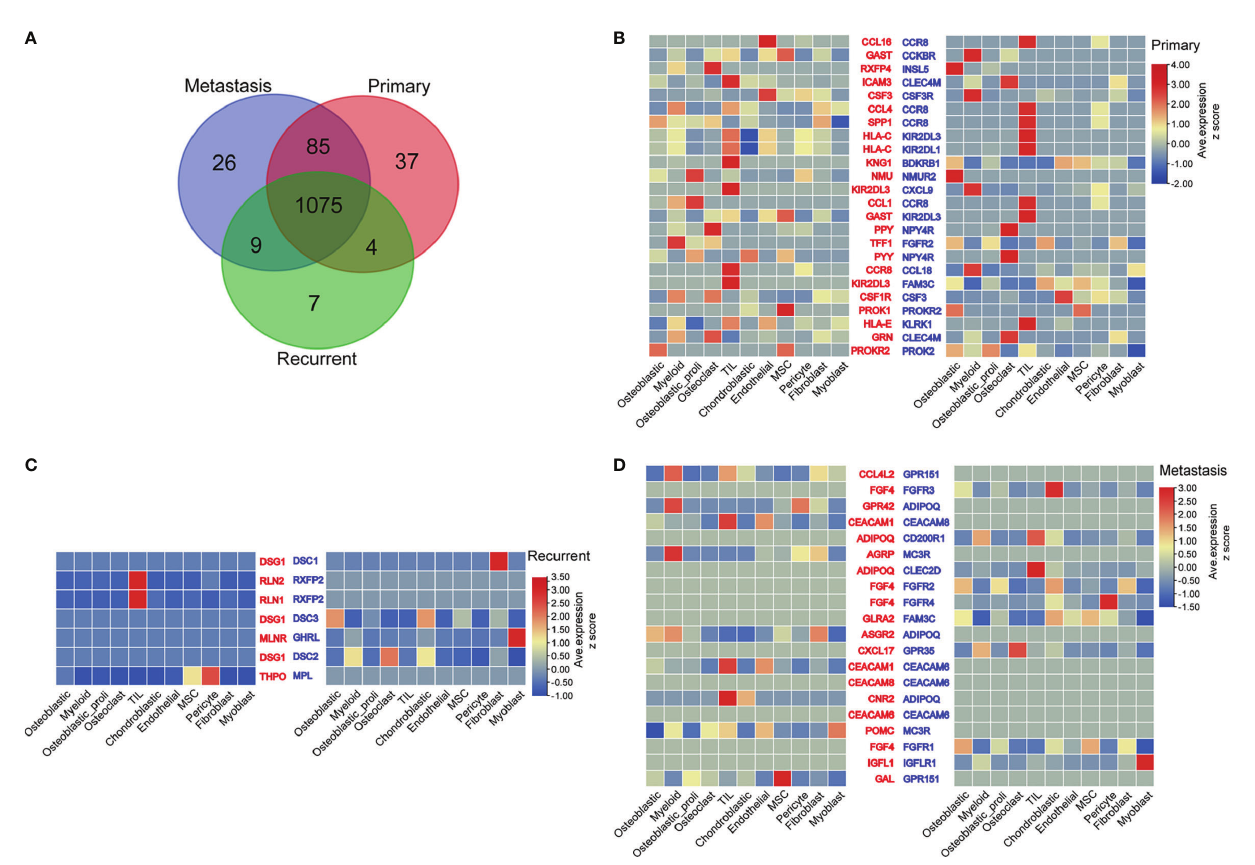
FIGURE 4 | Ligand – receptor interactions between various types of cells from primary, metastatic, and recurrent osteosarcomas. (A) The common ligands/receptors in primary, metastatic, and recurrent osteosarcomas were illustrated as a Venn diagram. (B) The expression levels of ligands/receptors in all types of cells from primary osteosarcoma were shown as a heatmap plot. (C) The expression levels of ligands/receptors in all types of cells from metastatic osteosarcoma were shown as a heatmap plot. (D) The expression levels of ligands/receptors in all types of cells from recurrent osteosarcoma were shown as a heatmap